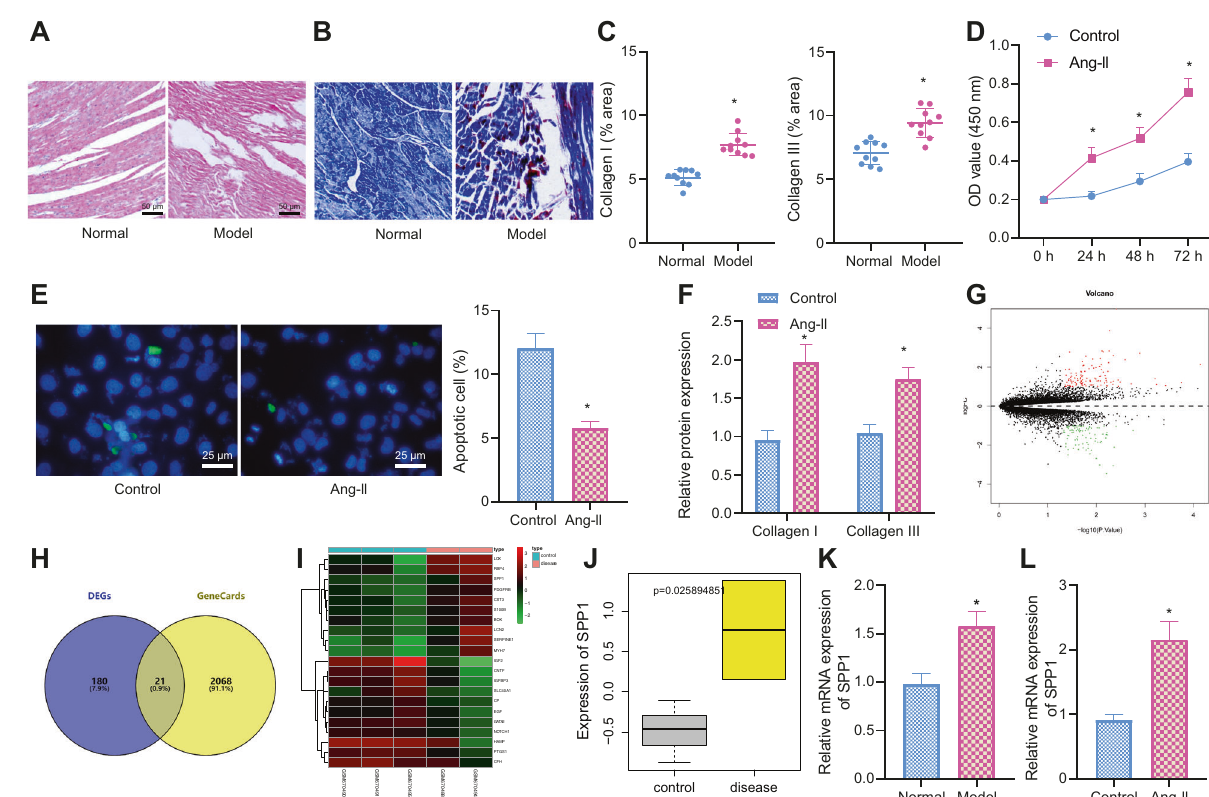
Fig. 1 Mouse and cell models of atrial fi brosis exhibit abundant SPP1 expression. A HE staining of pathological changes of atrial tissues in normal and Ang II-treated mice. B Masson ’ s trichrome staining of atrial fi brosis degree in normal and Ang II-treated mice. Collagen fi bers were in blue and muscle fi bers were in red. C IHC analysis of collagen I and collagen III proteins in atrial tissues of normal and Ang II-treated mice. D CCK-8 detection of cell viability in control and Ang II-induced HL-1 cells. E TUNEL detection of apoptosis of control and Ang II-induced HL- 1 cells. F Western blot analysis of collagen I and collagen III proteins in control and Ang II-induced HL-1 cells. G A volcano plot of differential genes in the GSE27133 dataset. The abscissa indicates − log10 ( p- value), and the ordinate indicates log2FC value. H Venn diagram of the DEGs and atrial fi brosis-related genes. I A heat map of key candidate gene expression. The color scale from blue to red indicates the increasing expression value. J SPP1 expression in atrial fi brosis samples in the GSE27133 dataset. K RT-qPCR detection of SPP1 expression in atrial tissues of normal and Ang II-treated mice. L RT-qPCR detection of SPP1 expression in control and Ang II-induced HL-1 cells. * p < 0.05, compared with the normal mice or control HL-1 cells. All experiments were repeated three times independently. n = 10 for mice in each